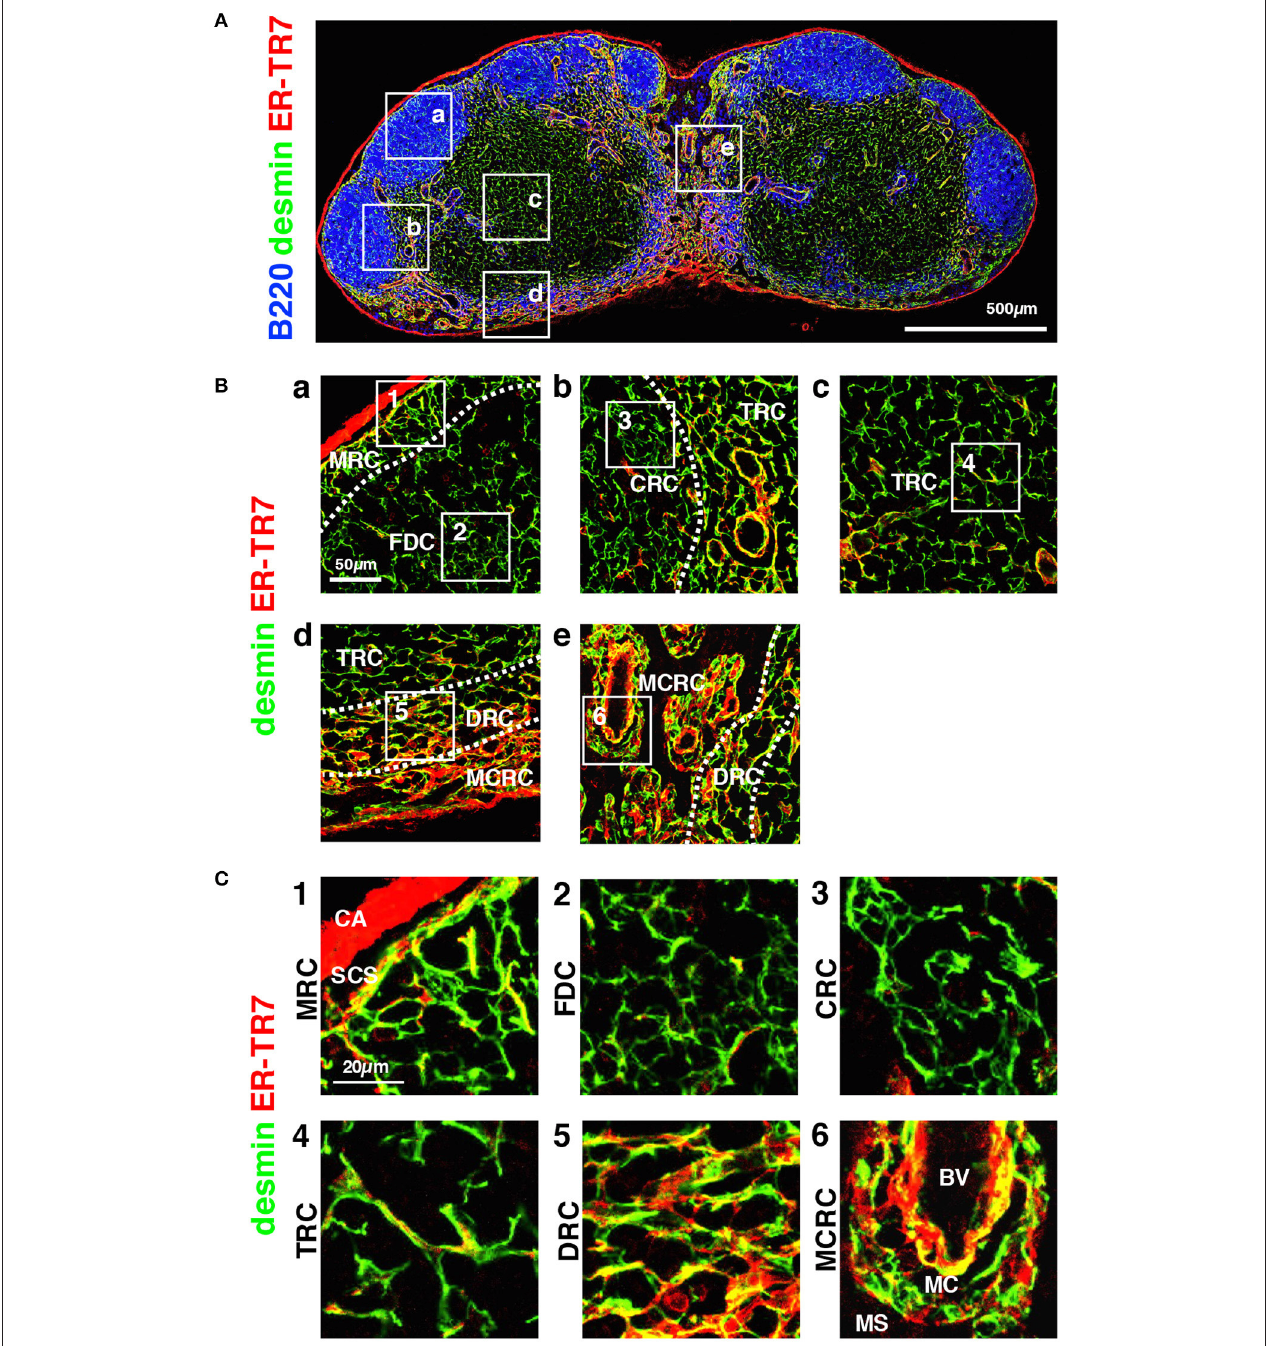
FIGURE 5 | Morphology and network structures of FSC subsets. (A) Whole view of an inguinal LN section with staining for B220, desmin, and ER-TR7. (B) Highly magnified z-projection images (1 µ m interval × 5) of the boxed areas (a–e) in (A) . (C) Higher magnification views of the boxed areas (1–7) in (B) . BV, blood vessel; CA, capsule; CRC, CXCL12-expressing reticular cell; DRC, DPC reticular cell; FDC, follicular dendritic cell; MCRC, medullary cord reticular cell; MRC, marginal reticular cell; SCS, subcapsular sinus; TRC, T zone reticular cell.